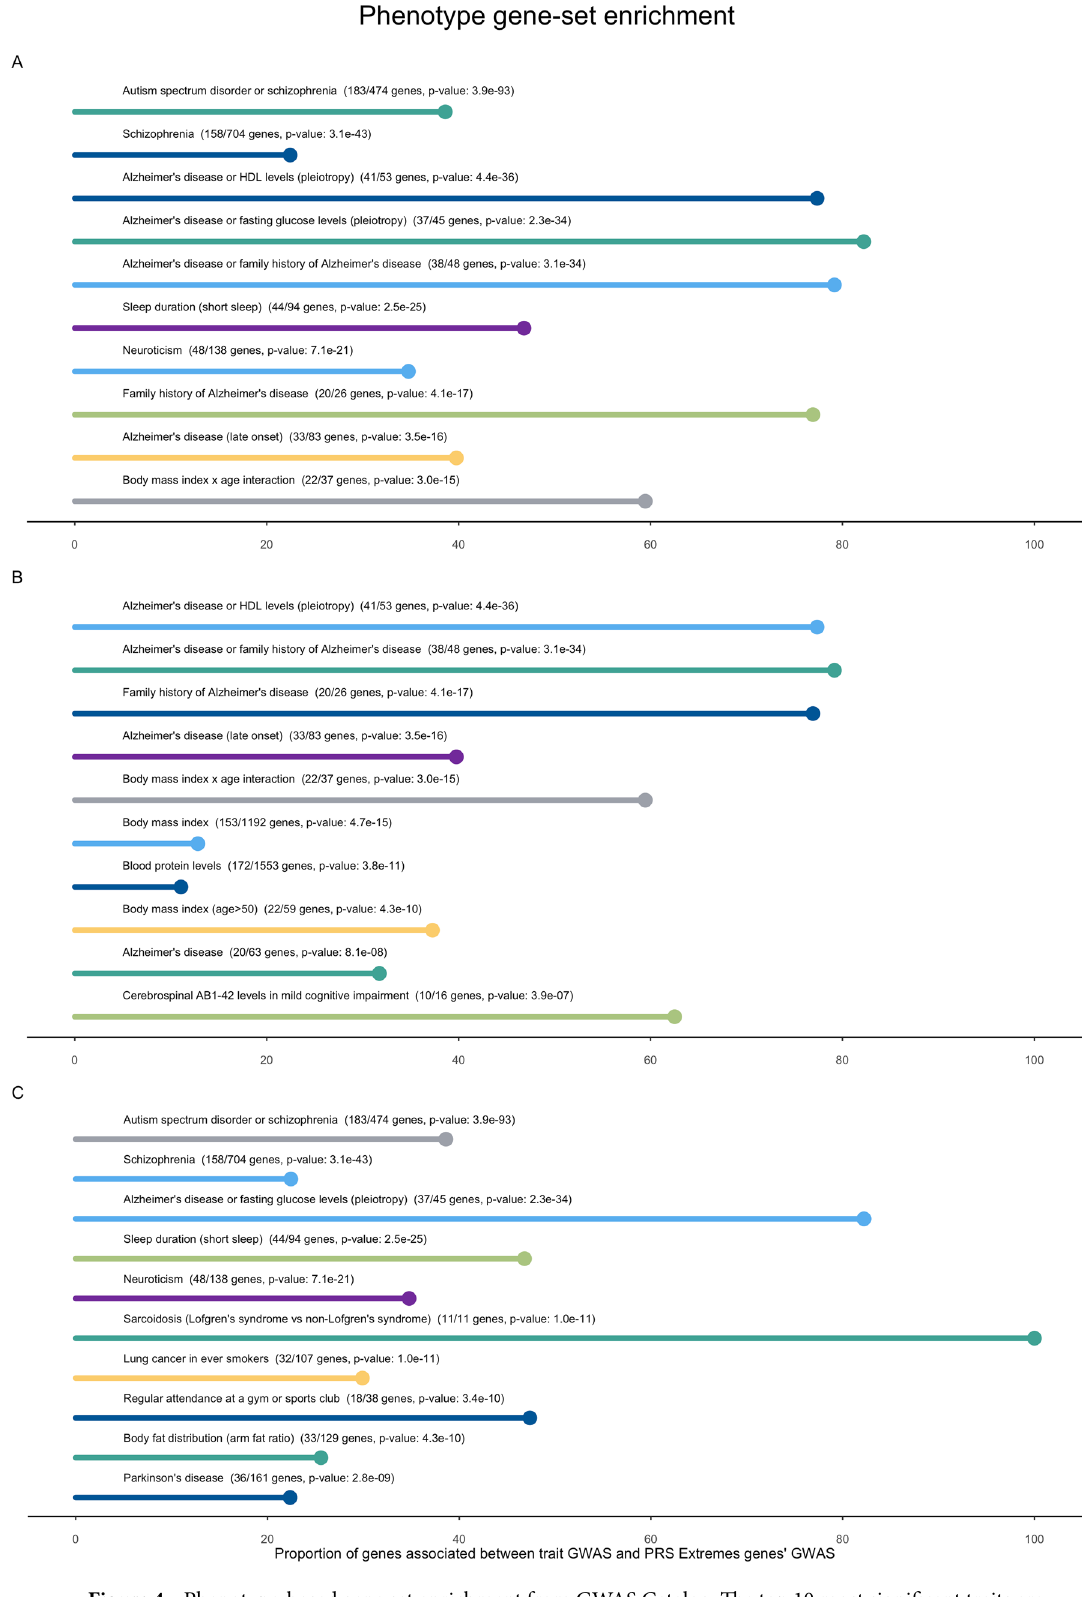
Figure 4. Phenotype-based gene set enrichment from GWAS Catalog. The top 10 most significant traits are shown in ( A ). The top 10 most significant traits where the overlapping genes include genes located in the APOE locus (chr19q13) are shown in ( B ) and the top 10 most significant traits where the overlapping genes do not include genes located in this locus are shown in ( C